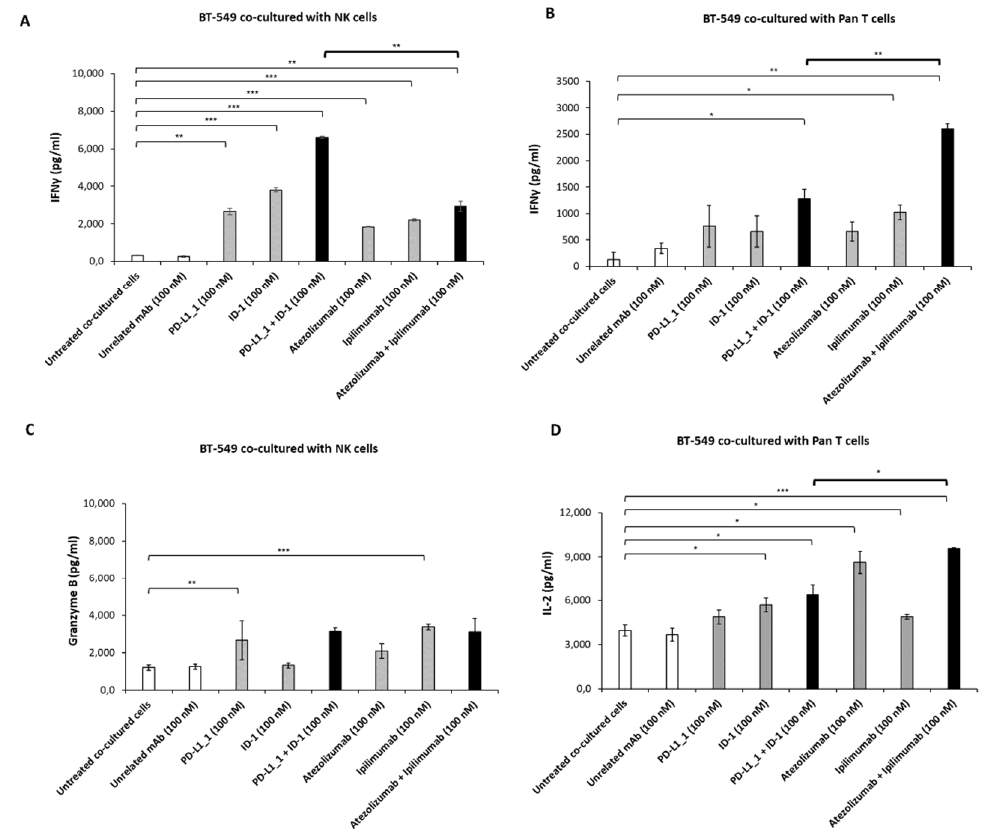
Figure 7. Cytokine secretion induced by immunomodulatory mAbs on co-cultures of BT-549 cells with NK or Pan T subpopulations. Tumor cells were co-cultured with NK ( A ) or Pan T cells ( B ) in the absence or in the presence of anti-CTLA-4, anti-PD-L1 mAbs used alone (grey bars) or in combination (black bars). Untreated hPBMCs or treated with an unrelated IgG were used as negative controls (white bars). The levels of IFN γ ( A , B ), Granzyme B ( C ) and IL-2 ( D ) secreted were measured by ELISA kits, as described above. The values were reported as the mean of at least three determinations obtained in three independent experiments. Error bars depict means ± SD. P-values were calculated by comparing each treatment with untreated co-cultured cells or comparing the two combinations with each other and reported as *** p < 0.001; ** p < 0.01; * p < 0.05.